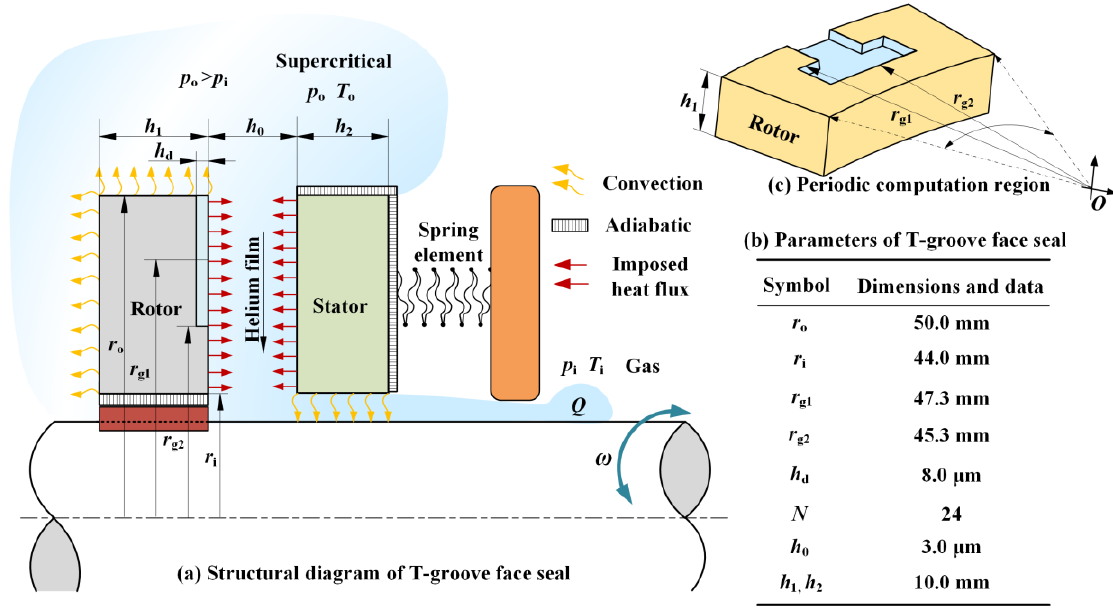
Figure 1. Geometry structure schematic diagram and thermal boundary conditions of the seals.